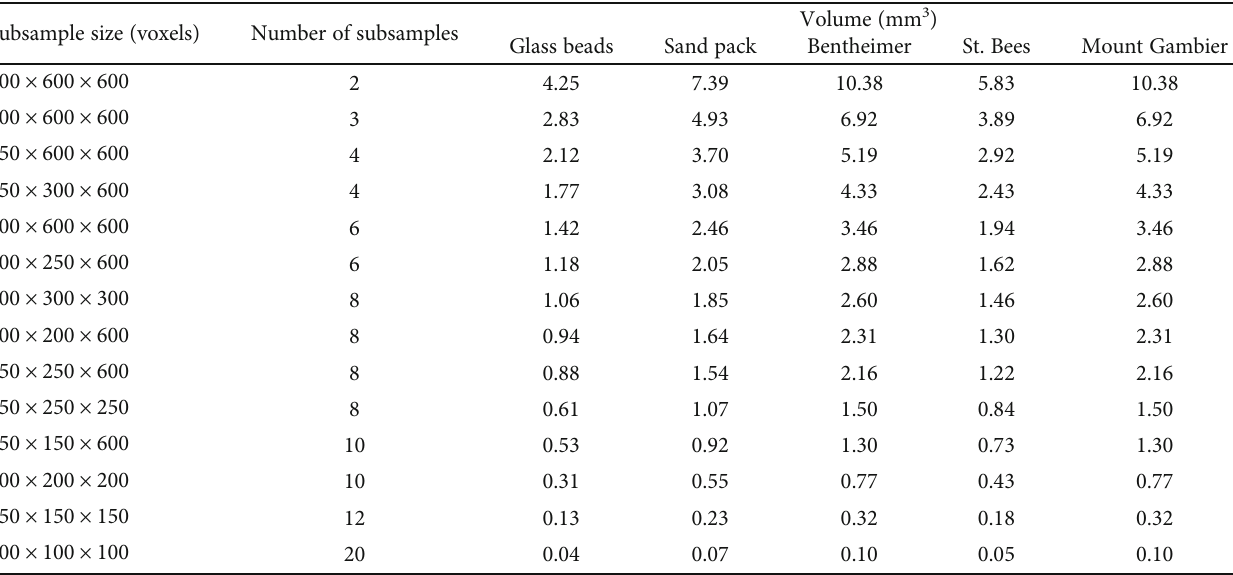
Table 2: Size of the subsamples